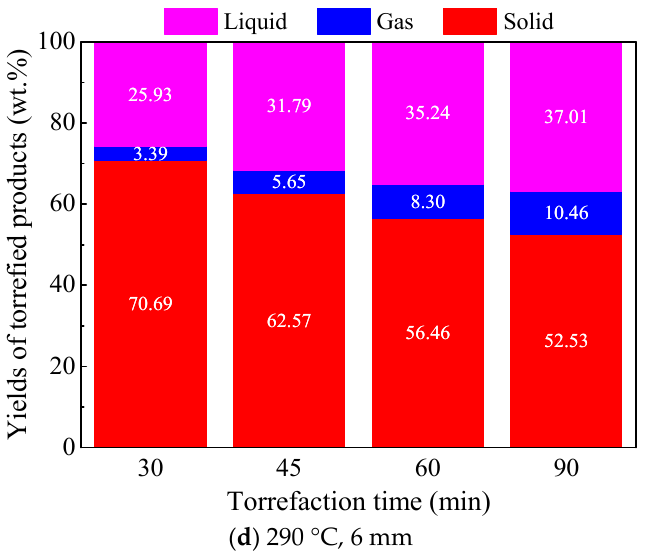
Figure 4. Product distribution of Paulownia wood torrefaction at 260 and 290 °C under different torrefaction times.